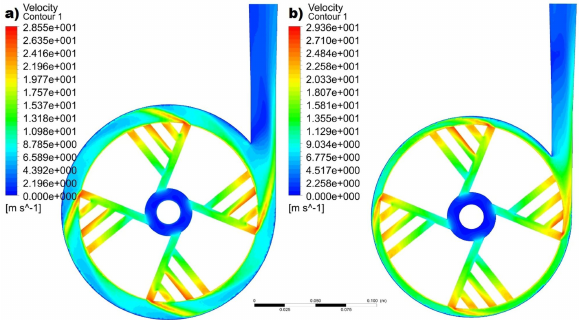
Figure 15: Distribution of liquid velocity on the model central plane (a) base annular casing VB and (b) final annular casing VM